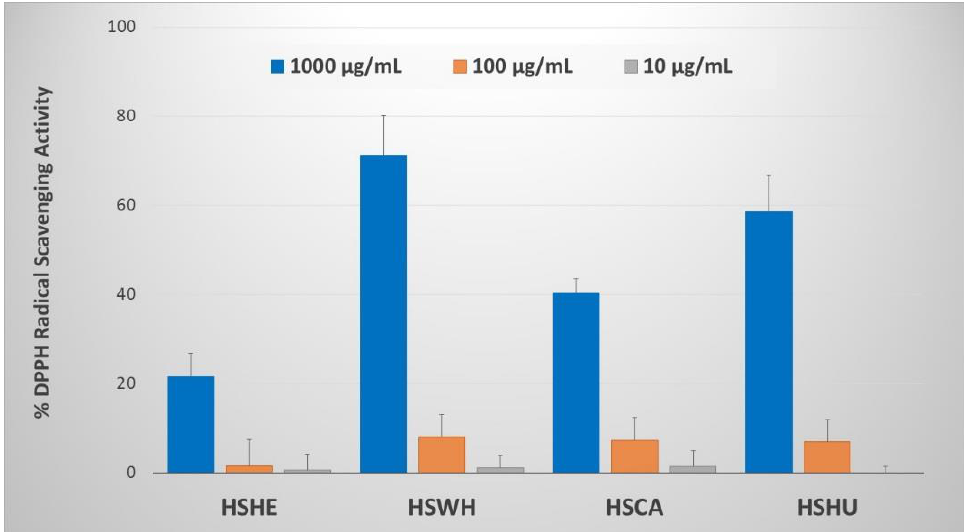
Figure 5. DPPH radical scavenging activity of protein isolates extracted from hemp seed and by- products. Data are expressed as the means ± SD (n = 3). HSHE — hemp hearts; HSWH — hemp whole products. Data are expressed as the means ± SD (n = 3). HSHE—hemp hearts; HSWH—hemp whole seed; HSCA — hemp cake; HSHU — hemp seed hulls. seed; HSCA—hemp cake; HSHU—hemp seed